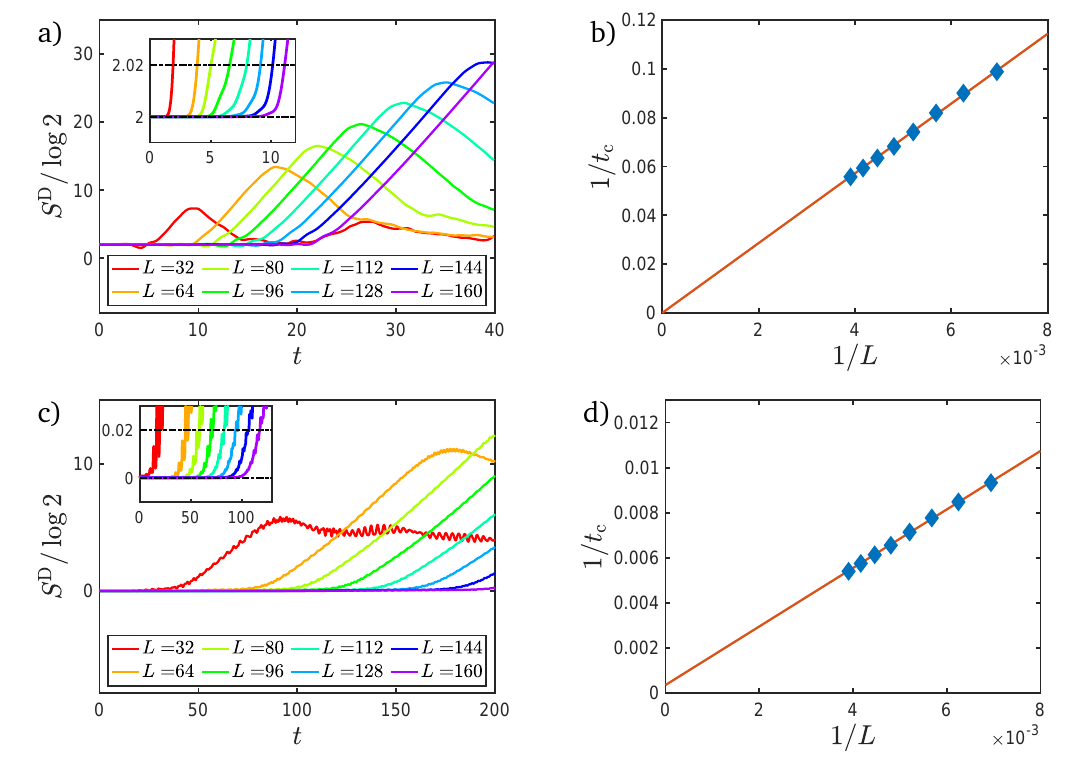
Figure 4: (Color online) a) and c) Time evolution of S D after quenching the Hamiltonian from a) v / w = 0.1 (topological phase) to v / w = 1.5 (trivial phase) and c) v / w = 1.5 to v / w = 0.1 at t = 0 and for different total length L = L = 2 L = L / 2. S D remains at its initial value until finite-size ef- with L A B D fects change it at t ∼ t . Insets: zoom on the graph around t ∼ t c